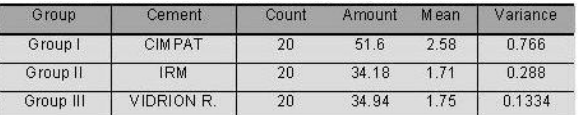
TABLE 1- Demonstration of the amount, mean in mm and variance